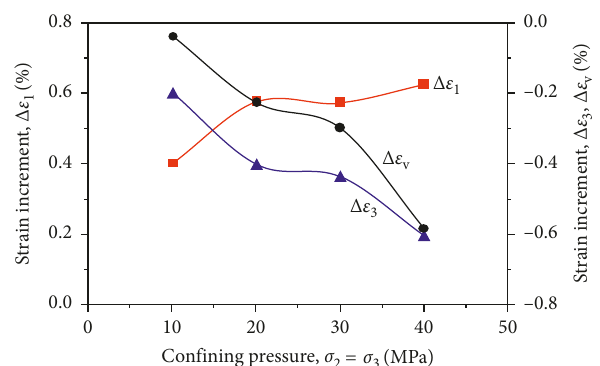
Figure 11: Variation in strain increment in the unstable crack growth stage under the conventional triaxial